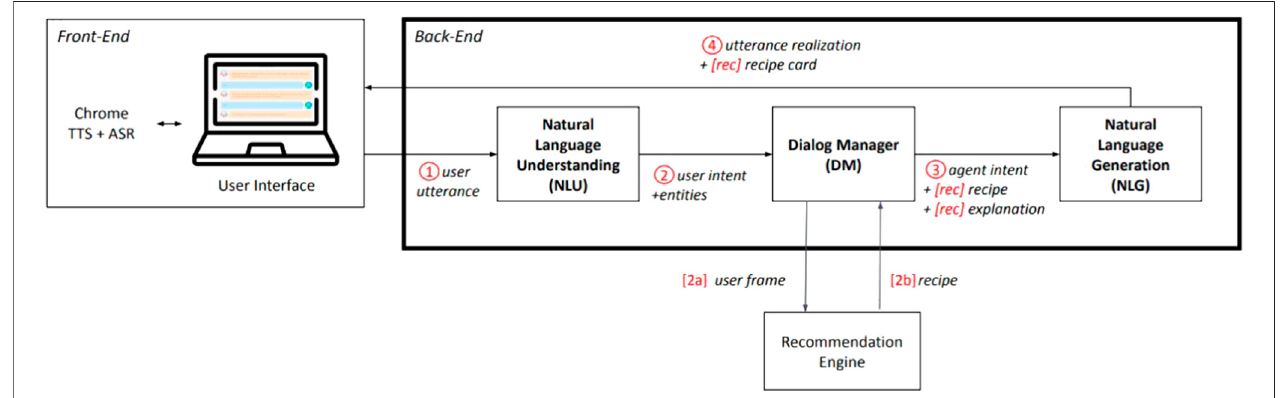
FIGURE 1 | Architecture of Cora, our COnversational Recommender Agent, with recommendation-only items preceded by